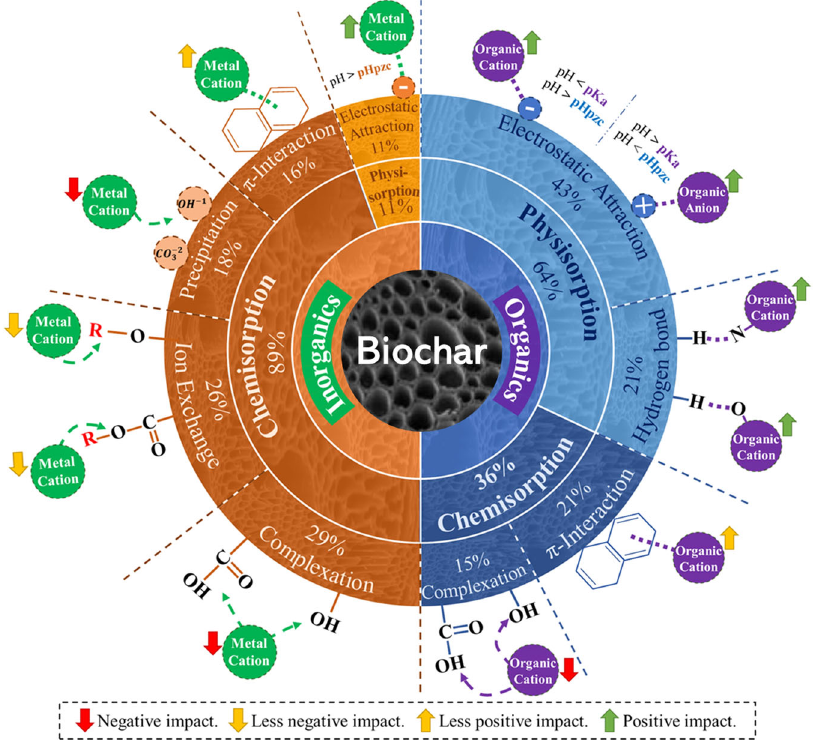
Fig. 7 Percentage of the dominant removal mechanisms, their functional groups, and their impact on the regeneration process. The dominant removal mechanisms found in literature, their corresponding driving FGs, and their impact on